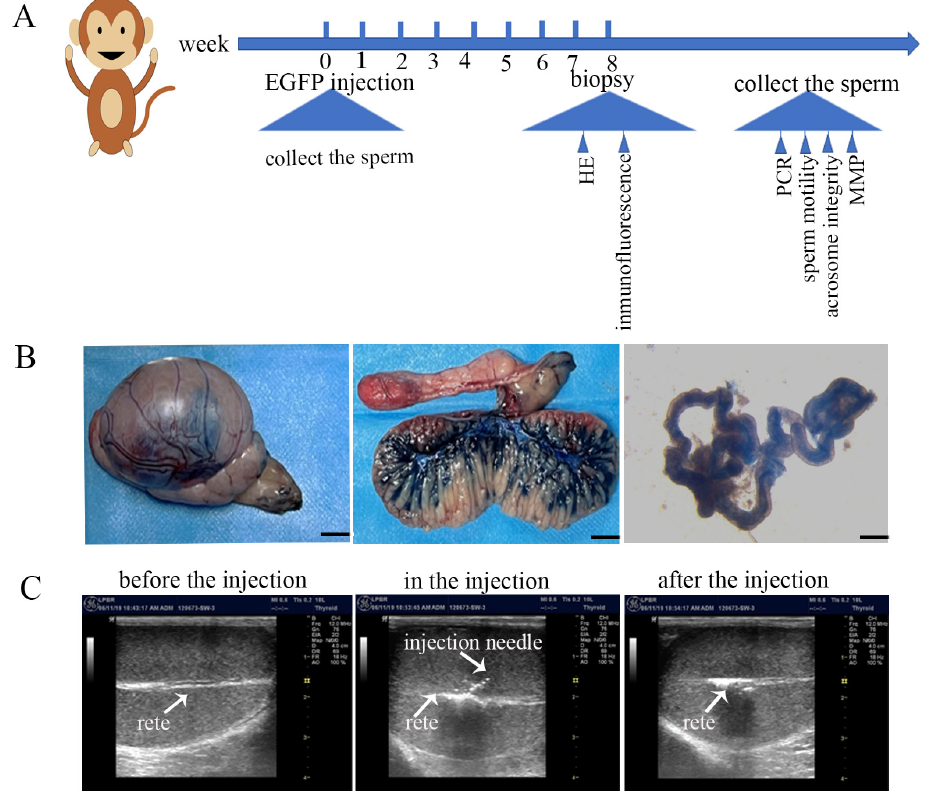
Figure 1. EGFP lentivirus injection: ( A ) Experimental timeline for EGFP lentivirus injection, testicular tissue and sperm collection; ( B ) Injecting of trypan blue staining solution (0.4%) or EGFP lentivirus into the rete testis and seminiferous tubules. The dilatation of rete after injection was confirmed by ultrasound. The rete and injection needle are indicated by the arrows; ( C ) Confirmation of successful injection of Trypan blue into rete testis. Bisection of the injected testis revealed that blue dye radiated rom the rete testis into approximately 60–80% of seminiferous tubules ( n = 3).